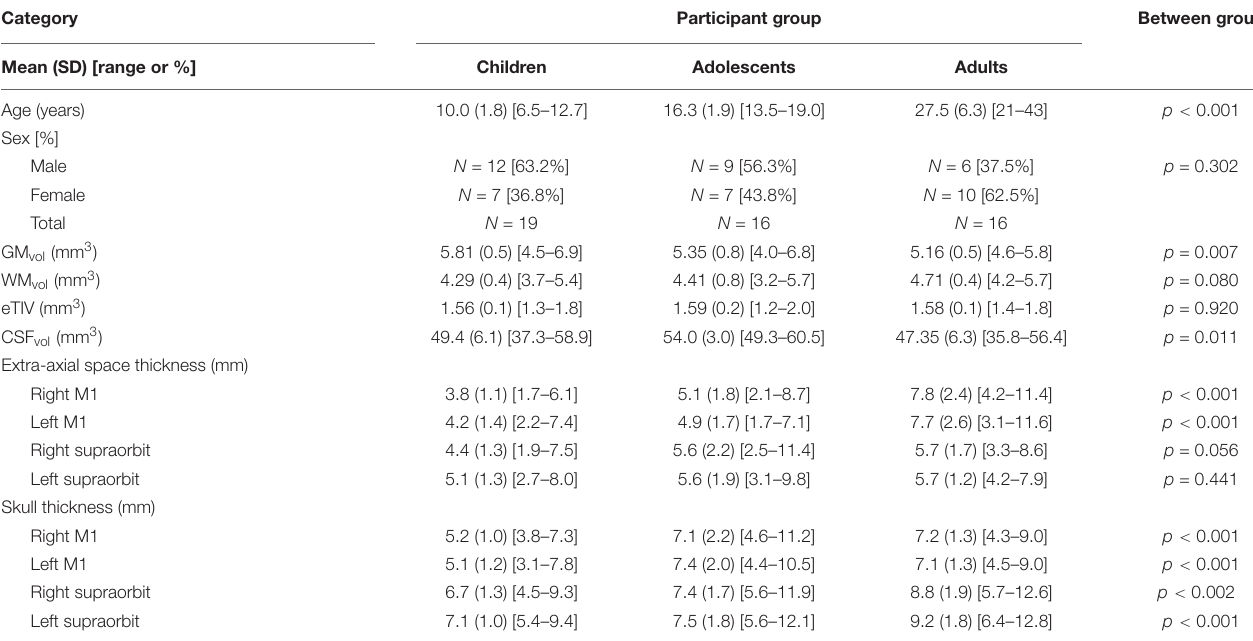
TABLE 1 | Demographics and tissue